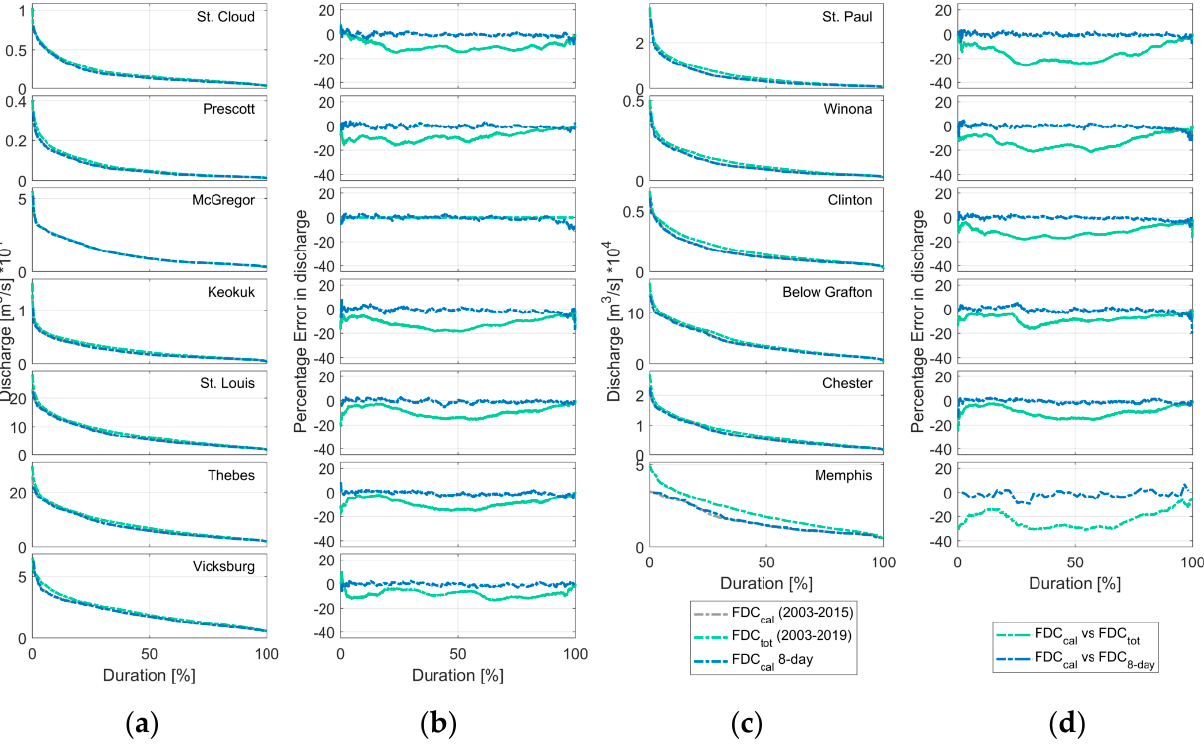
Figure 4. ( a , c ) show flow duration curves (FDCs) calculated for (i) the entire period (tot), from 2003 to 2019, (ii) for the selected calibration period (cal), from 2003 to 2015, and (iii) for the calibration period adopting an eight-day sampling interval for all the sites analyzed. ( b , d ) columns show differences in discharge between the FDCs built referring to the calibration and total period, and between the FDCs built in the calibration period, but in case of considering daily or eight-day sampling